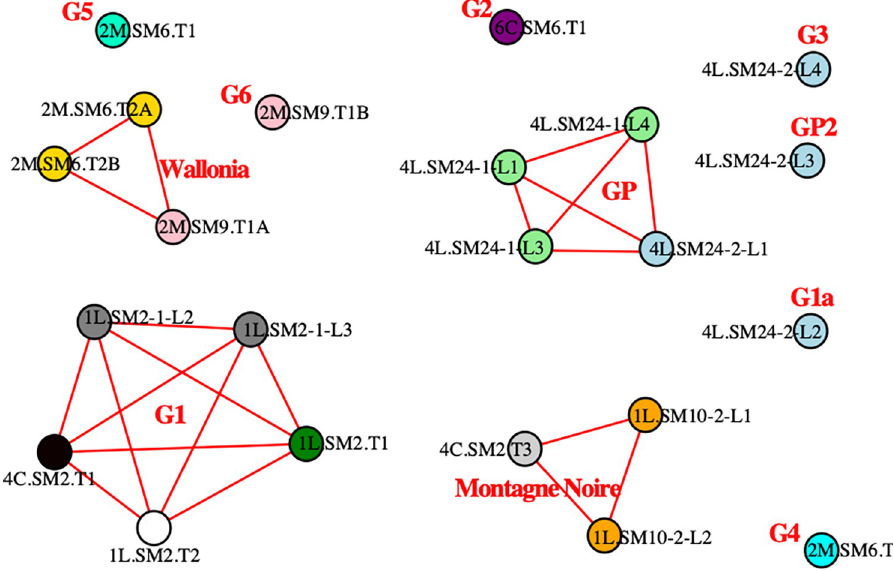
Fig 23. Network analysis: PPM from the same provenance are linked. PPM of the same color belong to the same bar. In red, the provenance network and name.